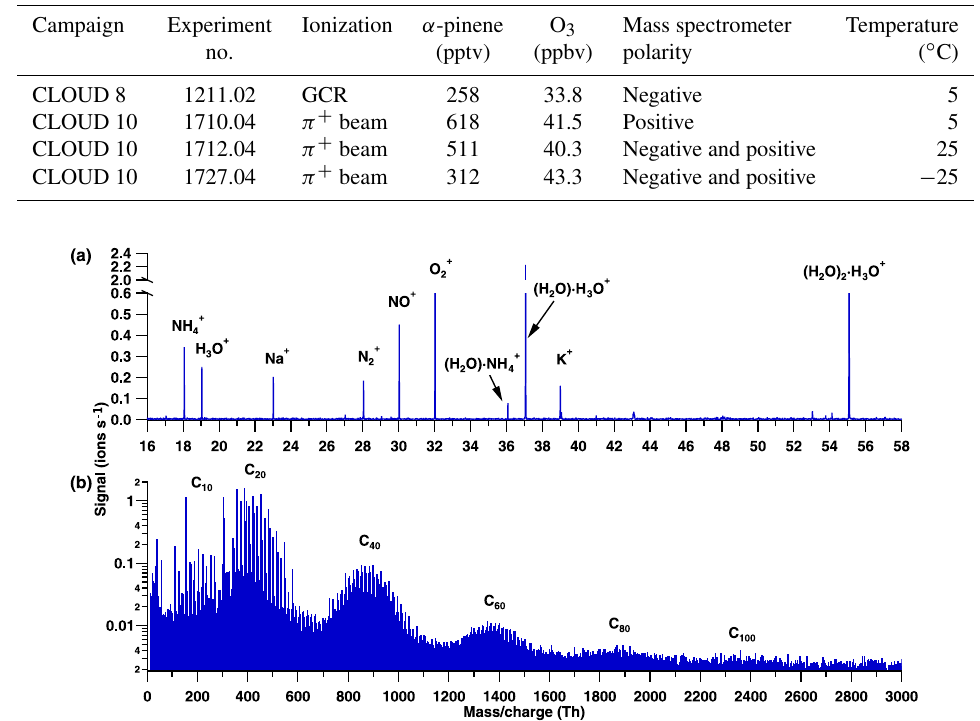
Figure 1. Positive spectra at 5 ◦ C. (a) Low mass region, where primary ions from galactic cosmic rays are observed, as well as secondary ions such as NH + , which are formed by charge transfer to contaminants. (b) Higher mass region during pure biogenic nucleation, which 4 shows broad bands in steps of C 20 . Most of the peaks represent clusters with NH +